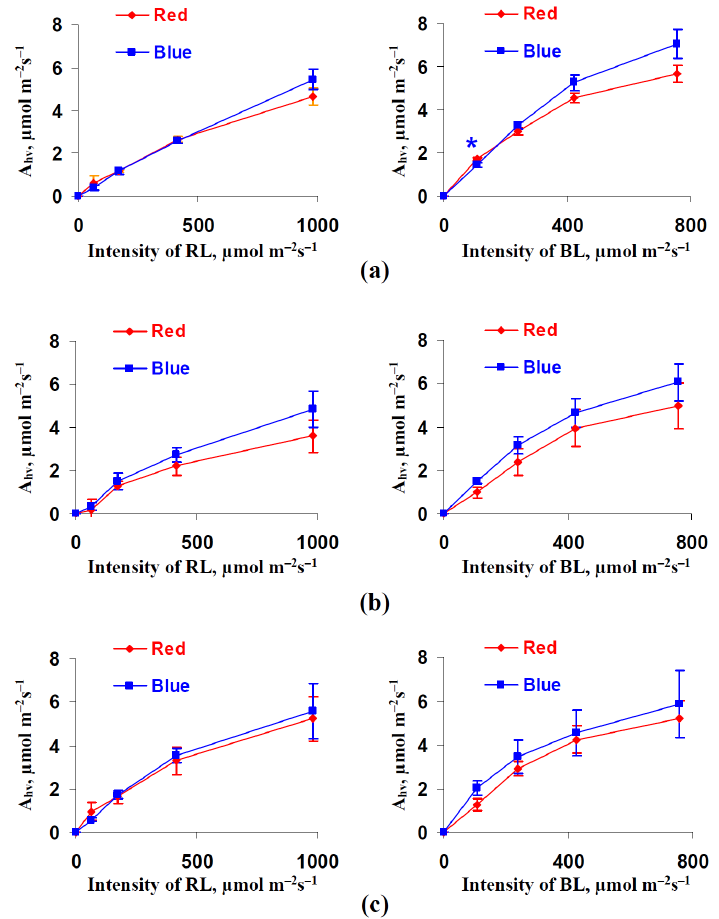
Figure 2. Dependences of the photosynthetic CO 2 assimilation (A hv ) on the intensity of the red actinic light (RL) (left panels) and blue actinic light (BL) (right panels) after 18 ( a ), 25 ( b ), and 32 ( c ) days of lettuce cultivation in the red (marked as “Red”) and blue (marked as “Blue”) illumination variants (see Figure 1) ( n = 5–7). A hv was calculated as the difference between the rate of the CO 2 assimilation under illumination by the RL or BL and this rate under dark conditions. * differences between plants cultivated in the red and blue illumination variants were significant ( p < 0.05). 3.2. Influence of Red and Blue Variants of Illumination on Parameters of Photosynthetic Light Reactions in Leaves of Lettuce Plants Furthermore, the photosynthetic light reaction parameter dependences (Fv/Fm, NPQ, LEF, and CEF) on the intensities of the red and blue actinic light in plants that had been cultivated in the red and blue illumination variants were investigated. It was shown (Figure 4) that the blue illumination variant resulted in a significant increase in the maximal quantum yield of photosystem II in the leaves of the lettuce plants after 18 and 25 days of cultivation; this effect was absent after 32 days of cultiva-